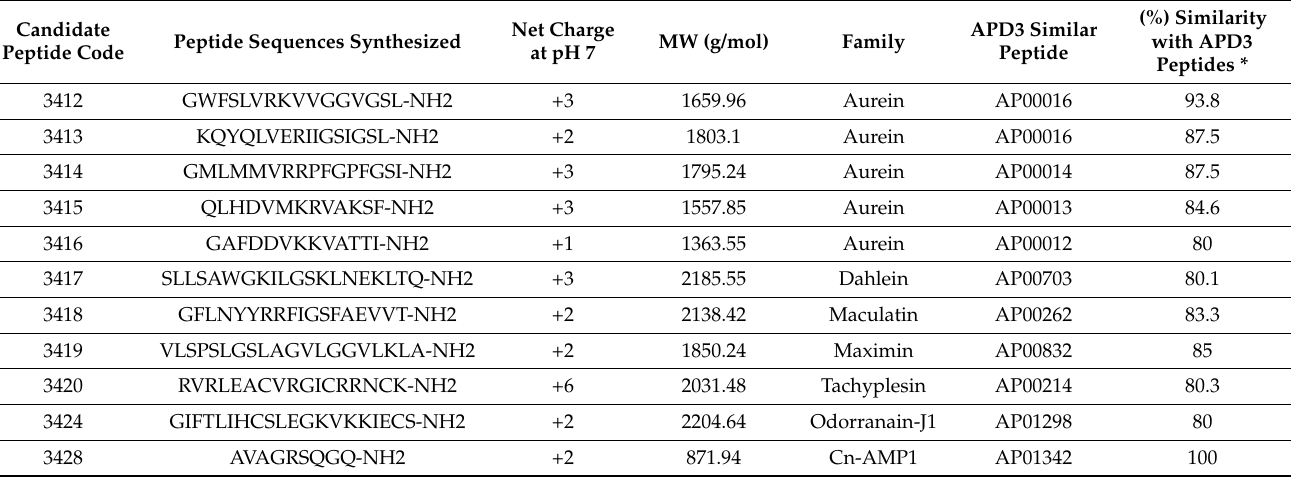
Table 2. Candidate peptides of B. ramosi chemically synthesized according to the similarity found with peptides in APD3